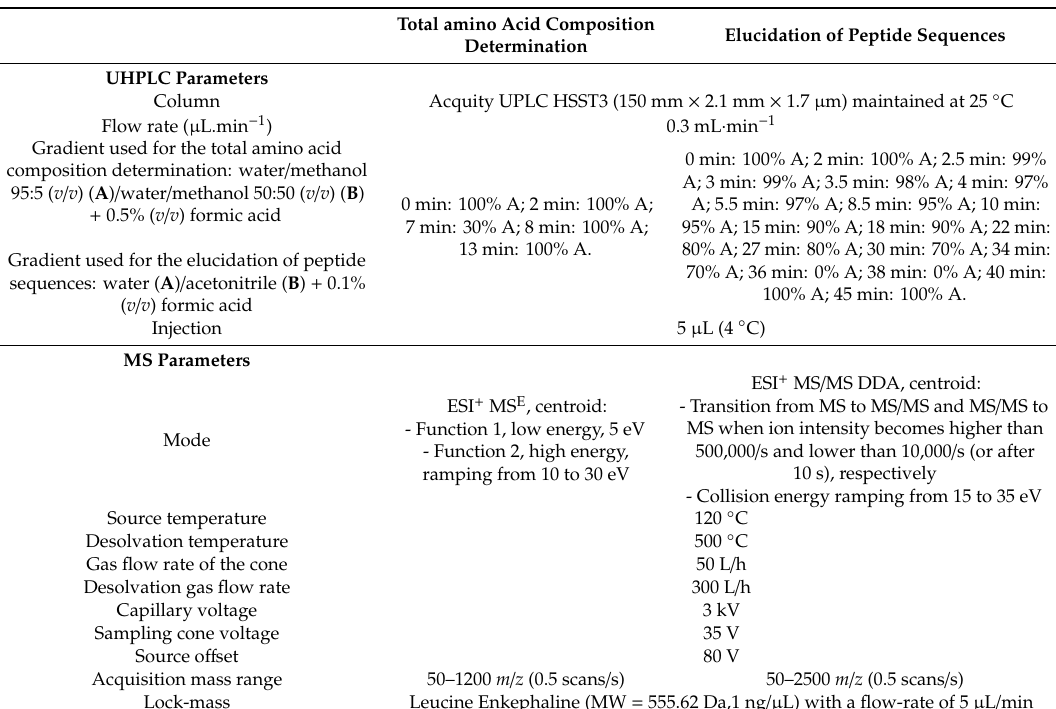
Table 3. Ultra-high-pressure liquid chromatography (UHPLC) and mass spectrometry (MS) parameters used to determine the total amino acid composition of the PROT-1 fraction and to elucidate the peptide sequences obtained in the H-PROT-1 (t1h)